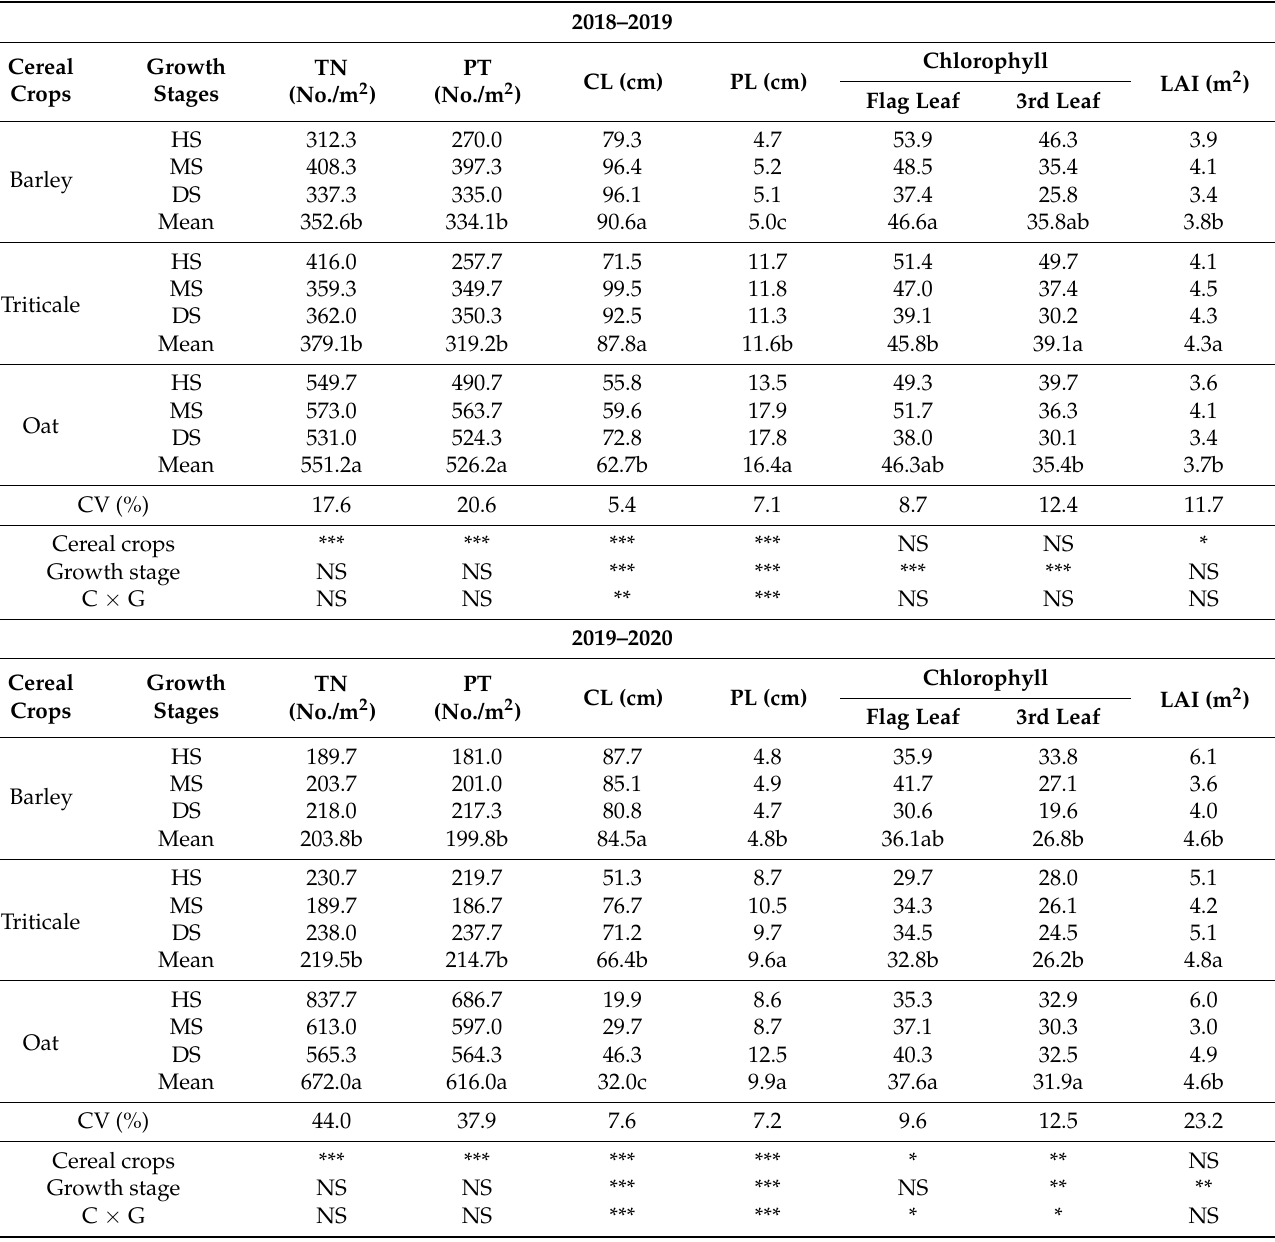
Table 3. Growth and development characteristics according to the growth period of three winter cereals for two